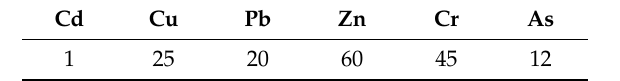
Table 5. Background concentration [mg / kg] used to calculate the contamination index.